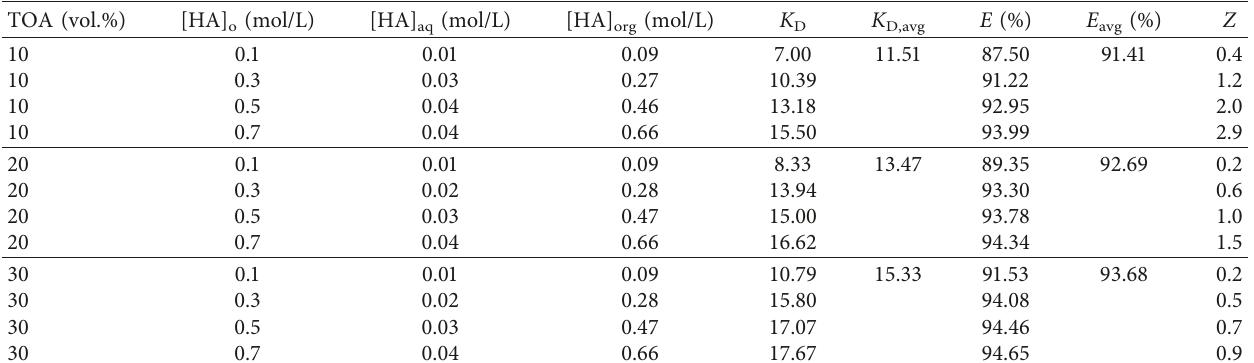
Table 4: Extraction equilibrium results for succinic acid and TOA in sesame oil biodiesel at 298K. TOA